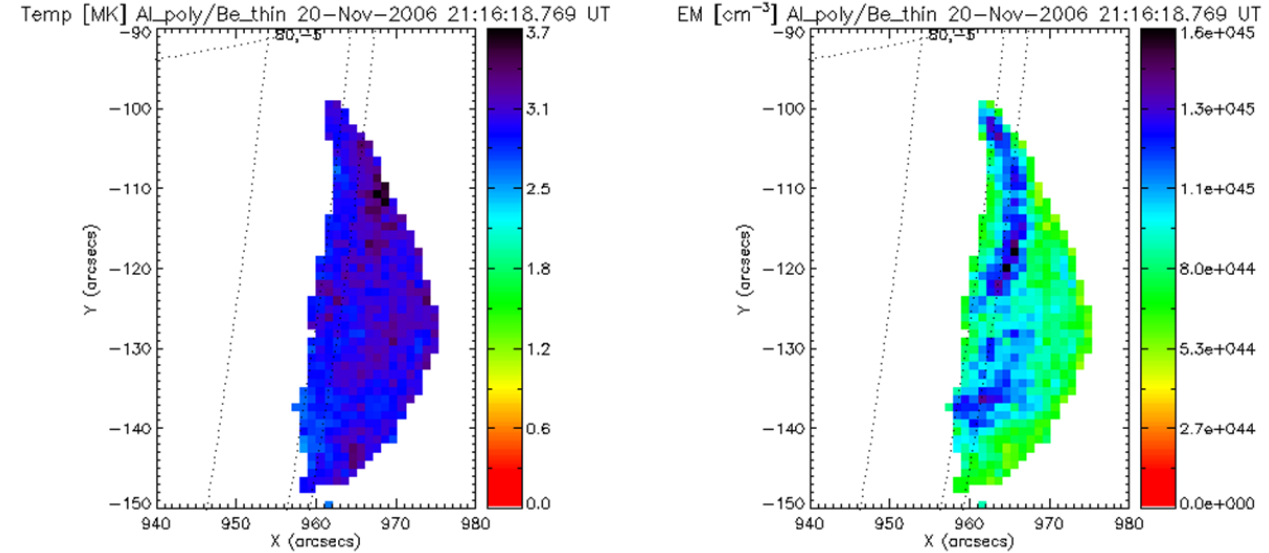
Fig. 3. Temperature and emission measure maps calculated from two filters ratio, Al poly/Be thin for the active region NOAA 0923 observed on West solar limb on 20 November 2006 at 21:16:19UT.